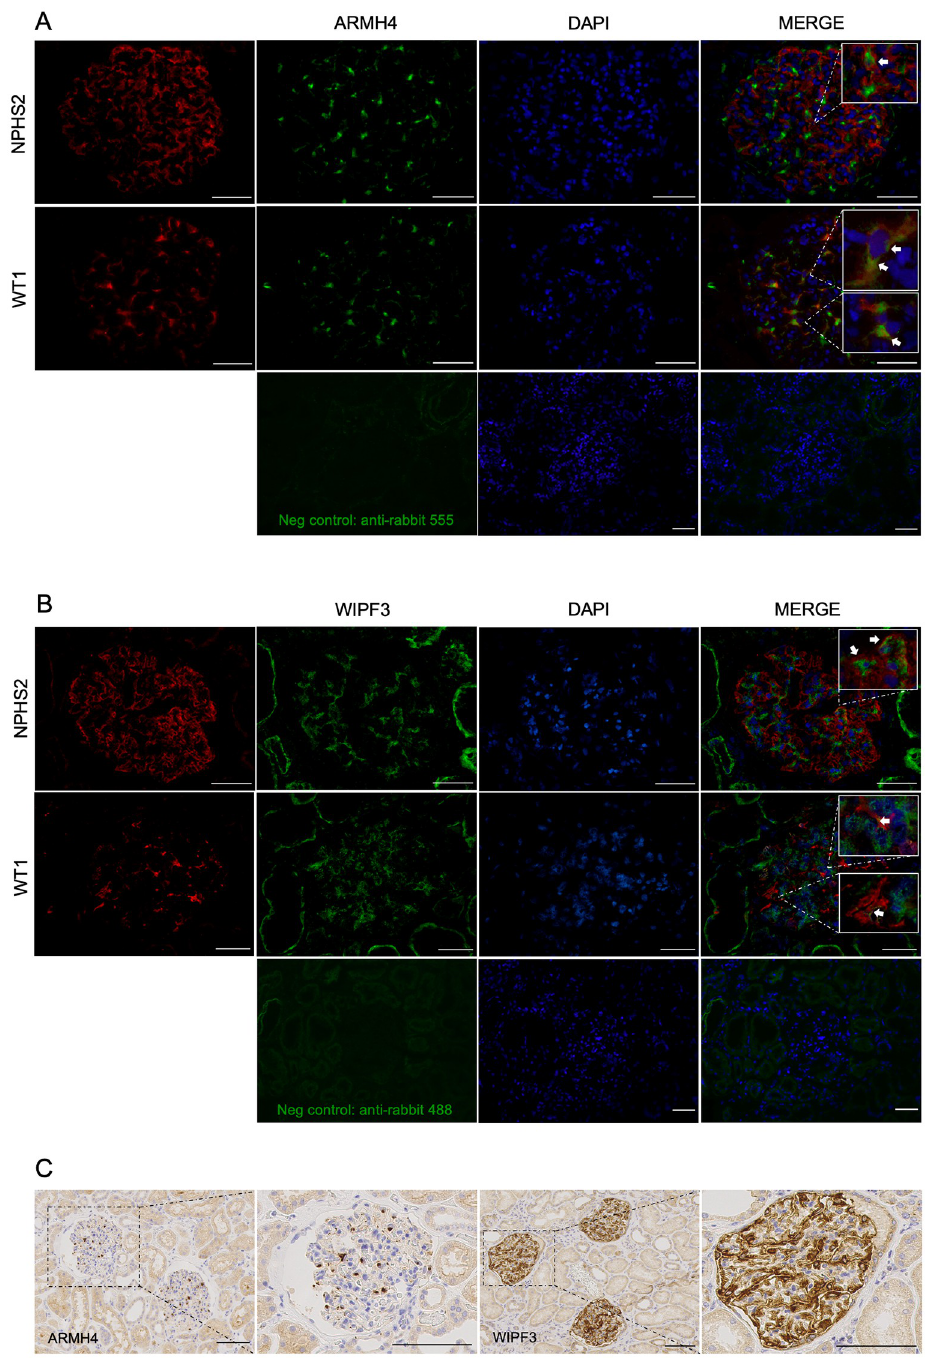
Fig 2. Confirmation of podocyte expression by immunostaining. Frozen human kidney sections (5 μ m) were double stained for the foot process marker NPHS2 or podocyte marker WT1 together with ARMH4 or WIPF3. A : ARMH4 shows perinuclear staining in cells that are outlined by NPHS2-positive contours, and ARMH4 is present in most of the cells that are positive for WT1. This is highlighted in the insets in the merged images to the right. B : WIPF3 immunoreactivity is observed in the cytosol of cells positive for NPHS2 or WT1. The upper inset in the merged images shows a cell body encircled by podocin that is also positive for WIPF3 and localized in close vicinity to podocyte foot processes. Bottom rows in A and B show negative control images for the primary antibodies used. Scale bars: 50 μ m. C : DAB staining (in brown) of 2 μ m thick paraffin-embedded kidney sections shows ARMH4 and WIPF3 immunoreactivity in glomerular podocytes. At higher magnification, ARMH4 shows an excentric perinuclear pattern, whereas WIPF3 seems to be distributed through the podocyte cytosol and along the glomerular basal membrane. Scale bars: 100 μ